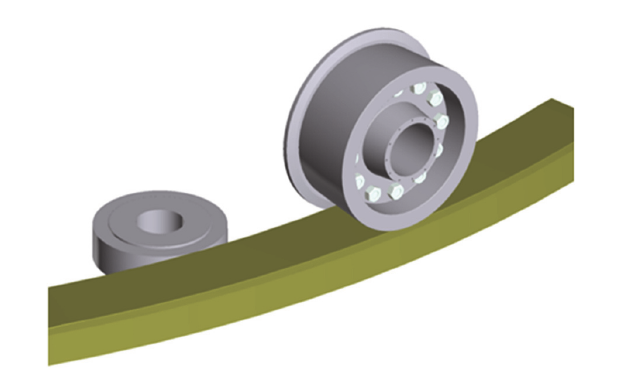
Figure 1: Wheel Rail connection, Ref.